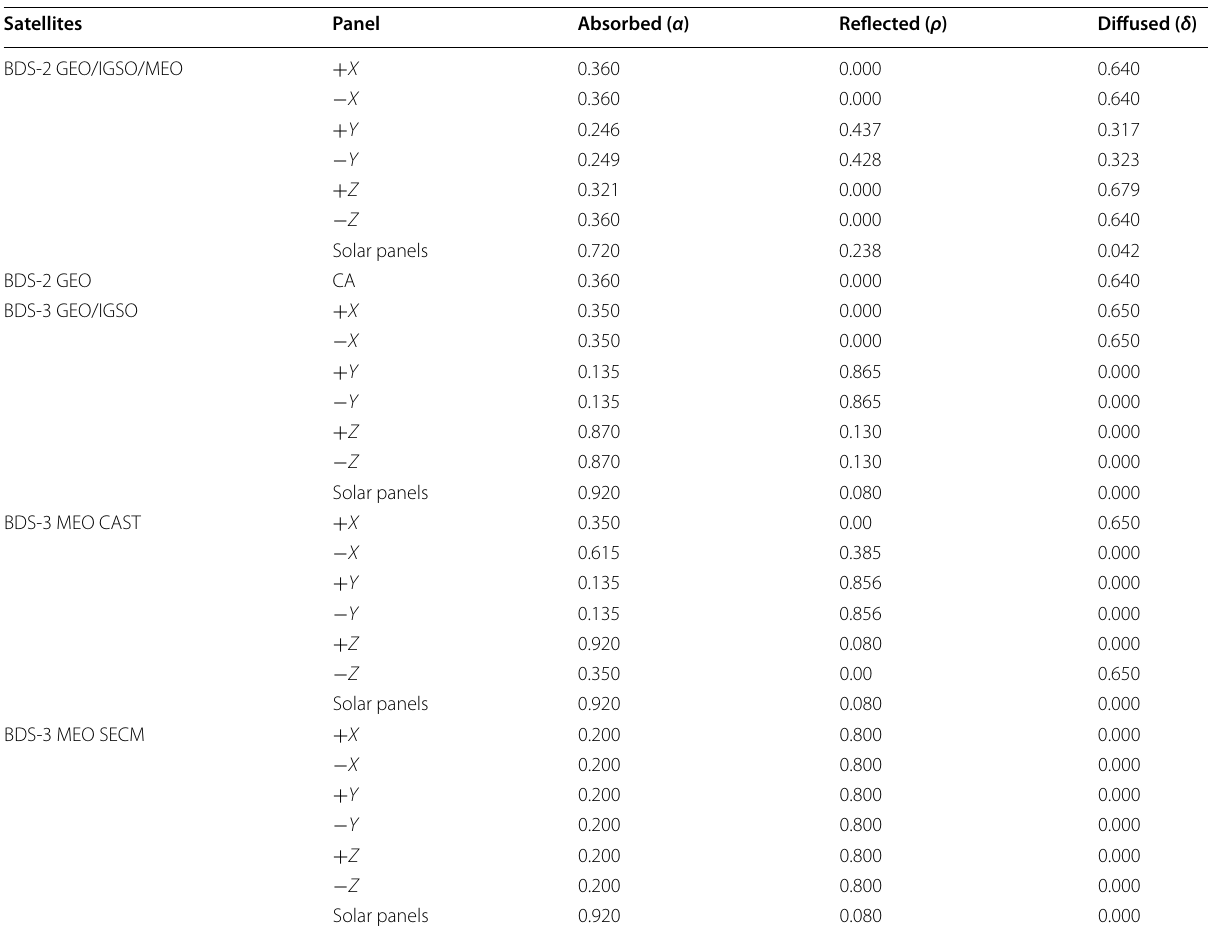
Table 3 The optical properties for BDS-2 and BDS-3 satellites Satellites